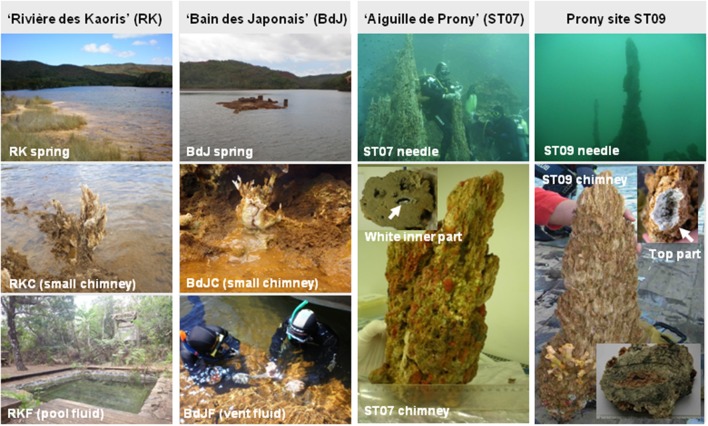
Intertidal and submarine hydrothermal sources of Prony Hydrothermal Field (PHF) in New Caledonia. Photographs show the sampling sites: “Rivière des Kaoris” (RK), “Bain des Japonais” (BdJ), “Aiguille de Prony” (ST07), and the Prony ST09 site. Suffixes “C” and “F” in site names stand, respectively, for chimney and fluid.